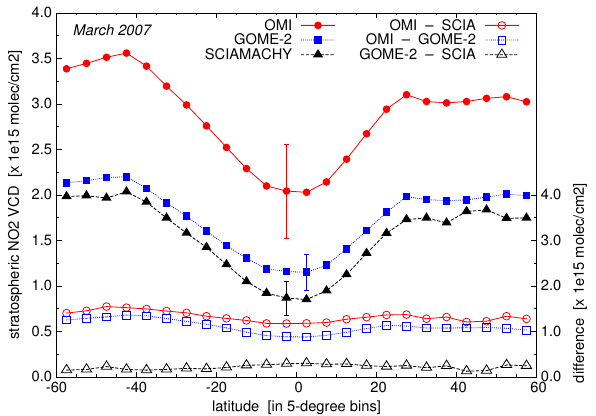
Fig. 1. Monthly average stratospheric NO 2 VCD values (left axis; filled symbols) and absolute differences Figure 1. Monthly average stratospheric NO 2 VCD values (left (right axis; open symbols) in 10 15 molec/cm 2 of OMI, GOME-2 and SCIAMACHY in March 2007 over the axis; filled symbols) and absolute differences (right axis; open sym- Pacific Ocean area ( 60 ◦ S – 60 ◦ N, 140 ◦ W – 180 ◦ W), as function of latitude. The error bars at the data bols) in 10 15 moleccm − 2 of OMI, GOME-2 and SCIAMACHY pointsneartheequatormarkforthatlatitudebintheaveragestandarddeviationofthetotalVCD.[Datasource: in March 2007 over the Pacific Ocean area (60 ◦ S–60 ◦ N, 140– http://www.temis.nl/] 180 ◦ W), as a function of latitude. The error bars at the data points near the equator mark for that latitude bin the average standard de- viation of the total VCD (data source: http://www.temis.nl/).